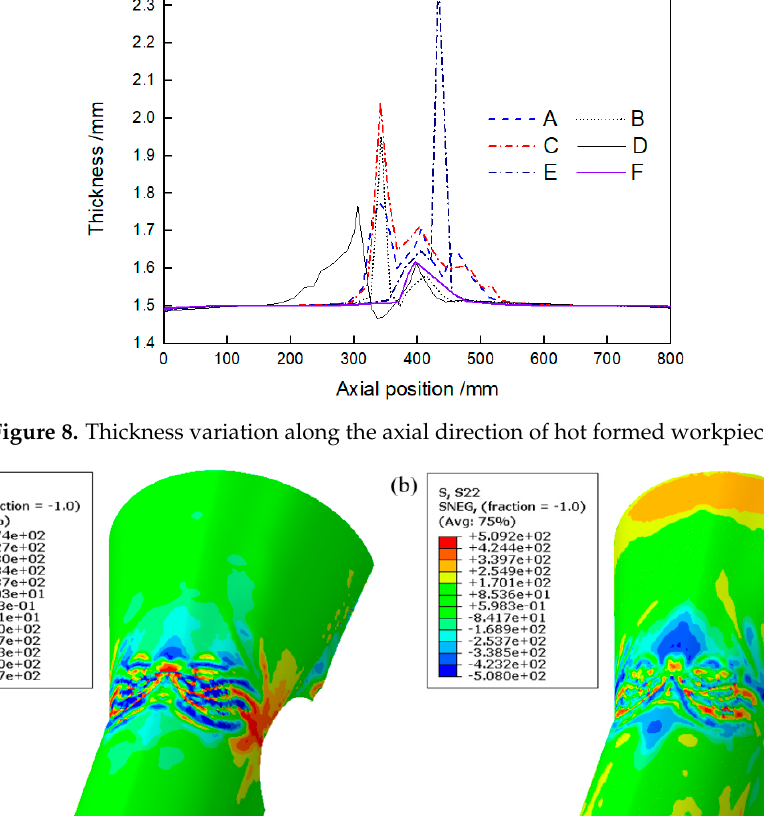
Figure 9. Stress distribution under initial blank F: ( a ) Axial stress; ( b ) hoop stress.